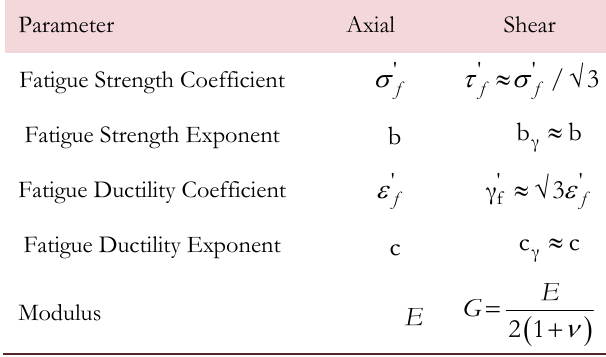
Table 2: Correlation between material fatigue parameters.